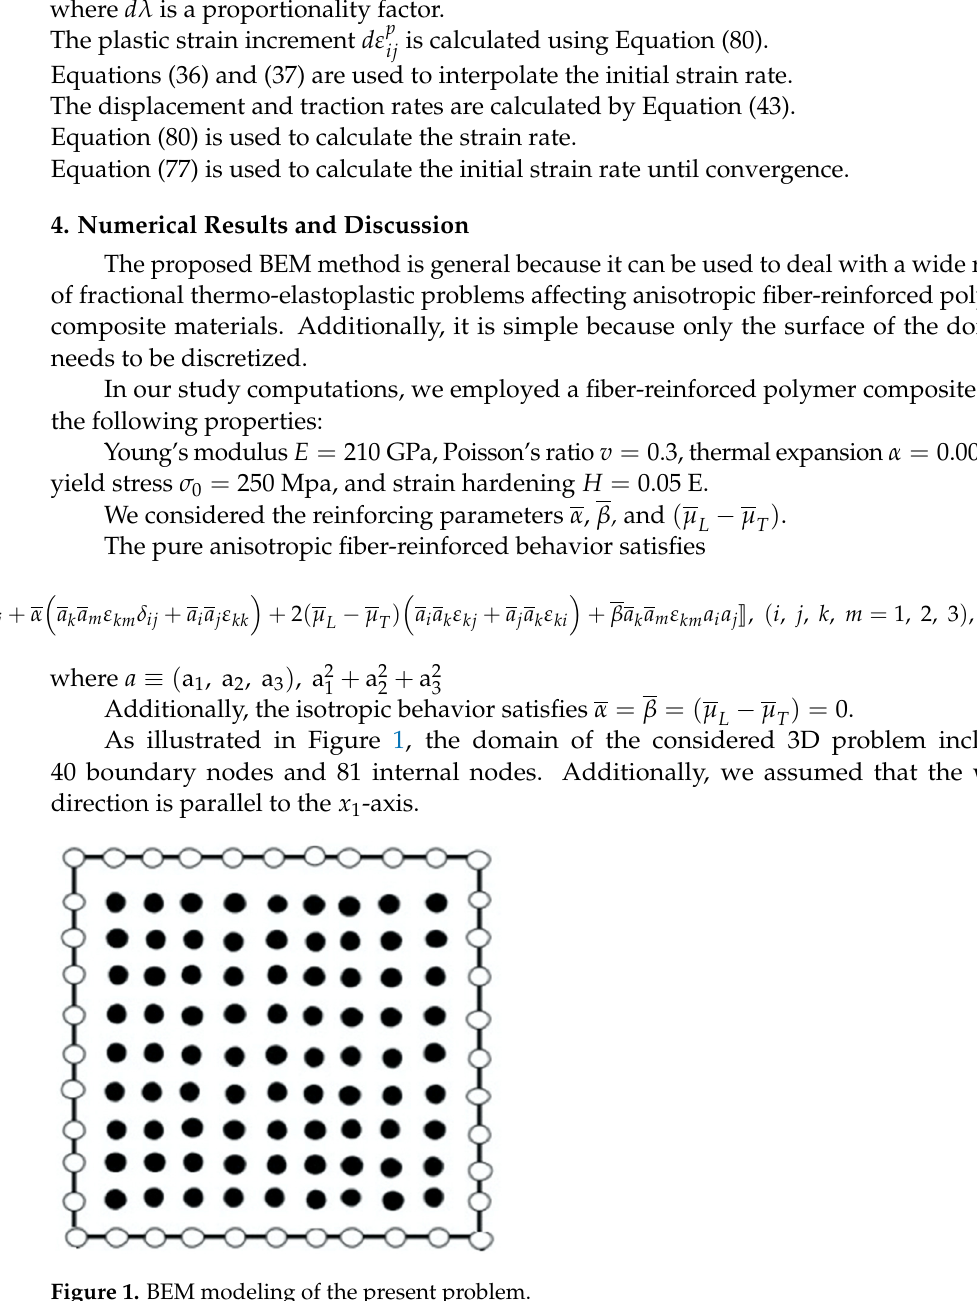
Figure 1. BEM modeling of the present